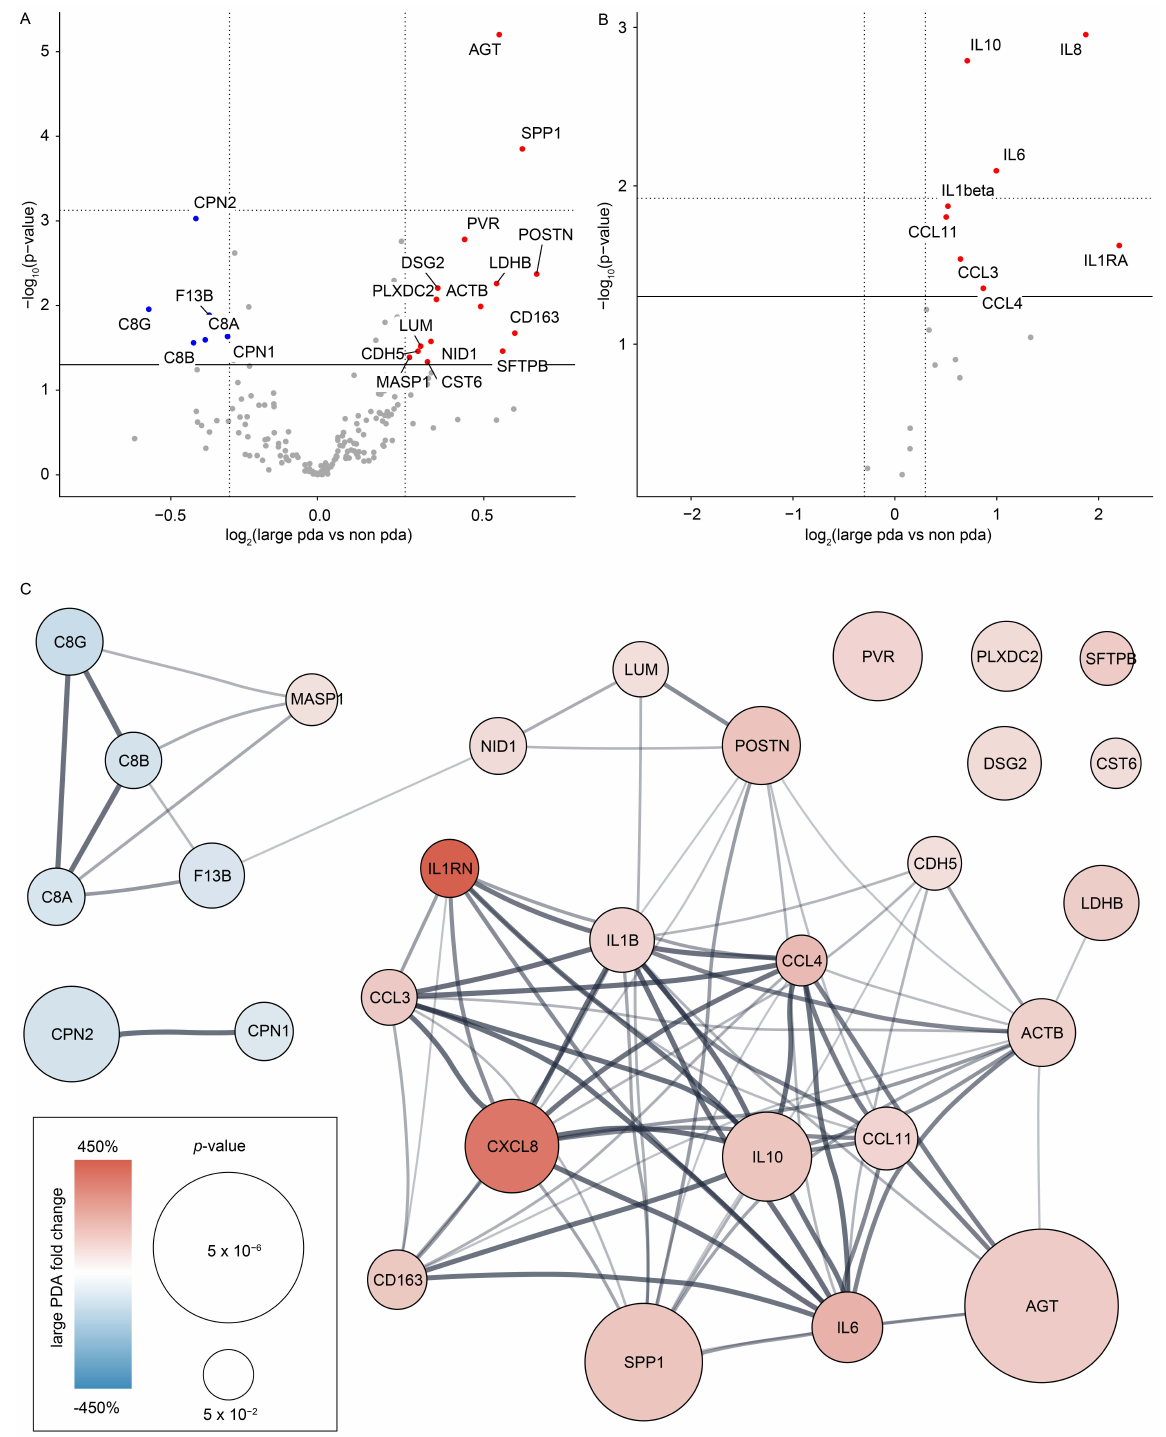
Figure 2. Large PDA and the plasma proteome. Data from 53 neonates born at a gestational age below 28 weeks. ( A ) Plasma proteome changes large PDA compared to no PDA as determined by LC-MS proteomics, and ( B ) immunoassay. Red (blue) proteins are increased (decreased) in PDA. Grey proteins are not significantly different. Gene names are provided. Horizontal solid line: p -value = 0.05, horizontal dotted line: q -value = 0.05, vertical dotted lines: Fold-change cutoff. ( C ) Combined analysis of the large PDA compared to no PDA changing plasma proteins. Color and protein size indicates PDA fold-change and statistical significance, respectively. Known protein–protein interactions from the STRING database are indicated by lines, where the width signifies the number of known